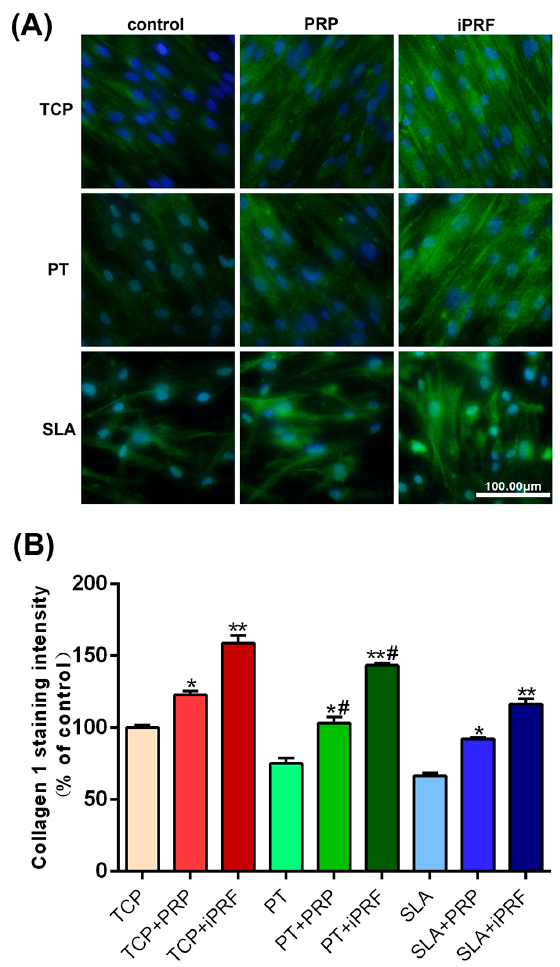
Figure 6. Immunofluorescent staining of collagen type 1 for human gingival fibroblasts seeded on TCP, PT and SLA surfaces with and without PRP and i-PRF at 7 days. ( A ) The merged fluorescent images of collagen type 1 staining (green) with DAPI staining (blue). (Scale bars = 100 µ m) ( B ) Quantified values of collagen type 1 staining in comparison to control TCP sample (* denotes significant difference between control and experimental group, p < 0.05, ** denotes significantly higher than all other groups, p < 0.05, # denotes significant difference between PT and SLA surfaces, p < 0.05).